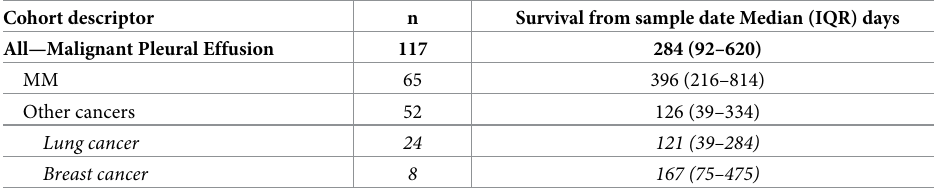
Table 1. Survival from sample collection in MPE cohorts.